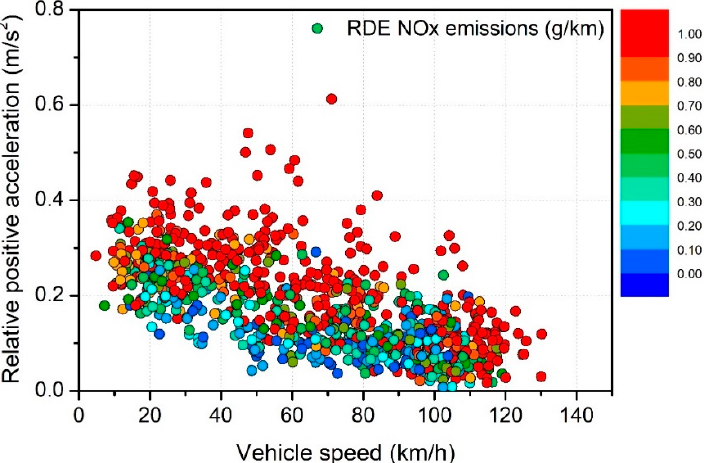
Figure 7. NOx emissions according to vehicle speed and relative positive acceleration in the Real Driving Emissions (RDE) test.